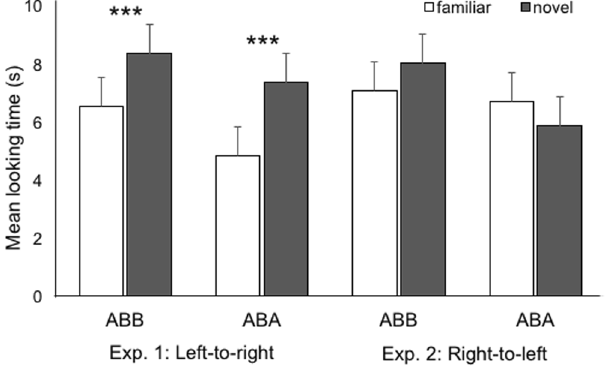
Figure 2. Mean looking times ( ± SE) to the familiar and to the novel test trials for infants presented with left- to-right oriented sequences in Experiment 1 and for infants presented with right-to-left oriented sequences in Experiment 2. Infants in Experiment 1 showed significantly longer looking times to the novel test trials than to the familiar test trials, whereas infants in Experiment 2 failed to discriminate between the two. *** p <